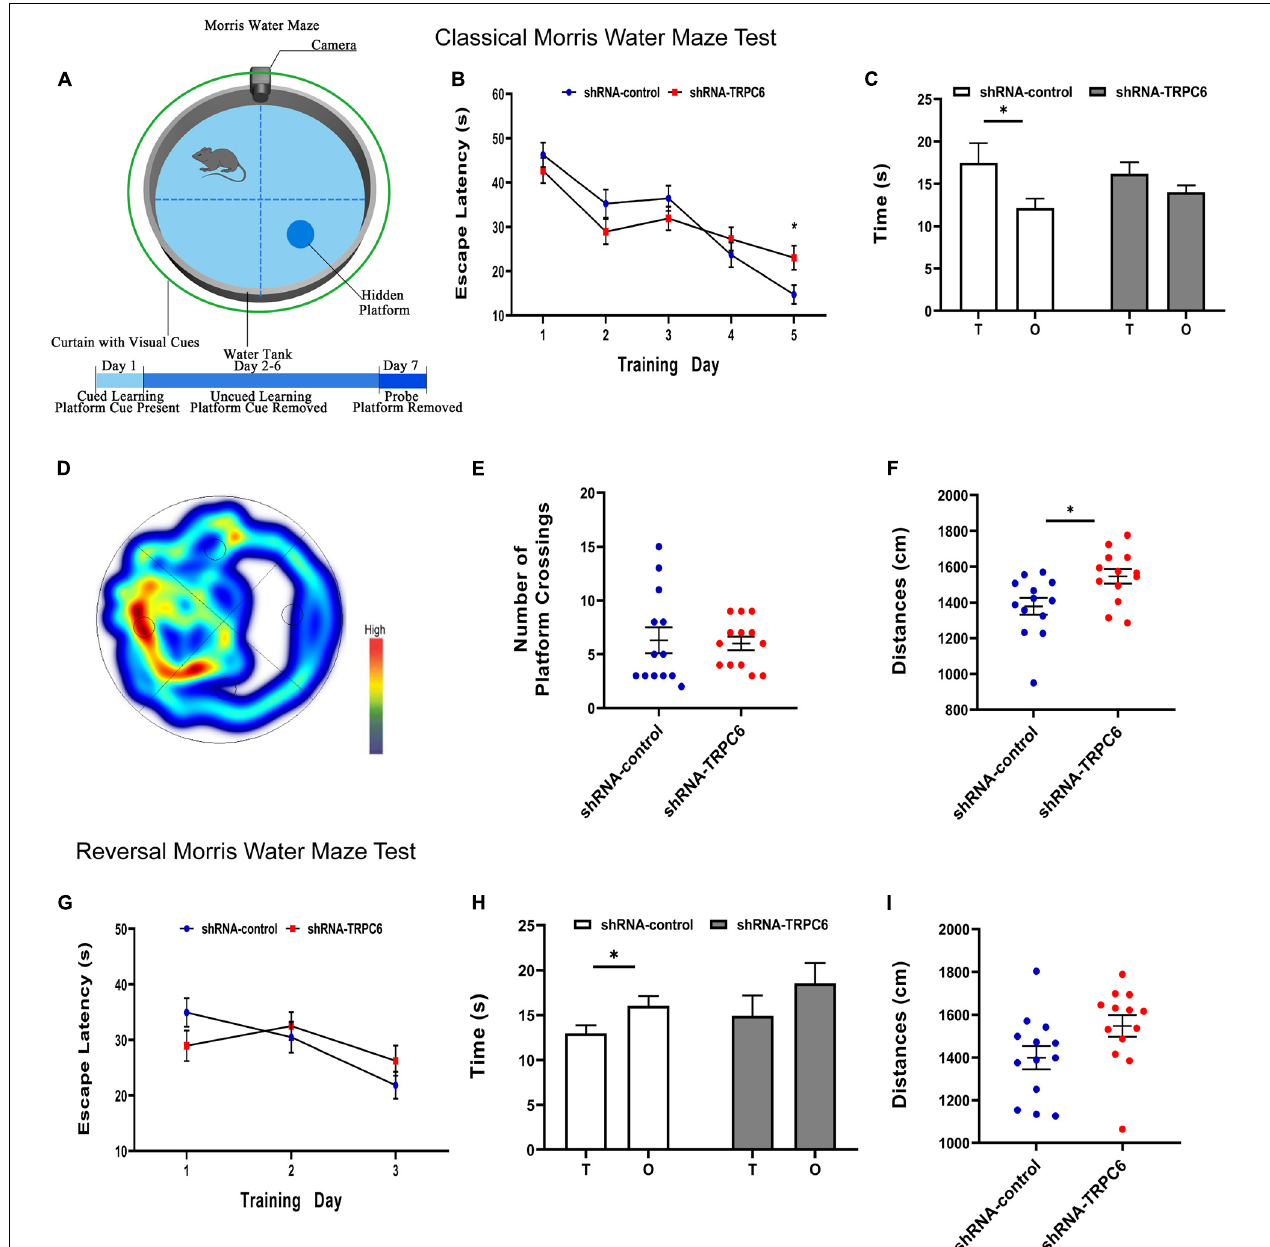
FIGURE 6 | Down-regulation of TRPC6 affected the spatial learning in the MWM test. (A) Experimental design in the MWM test. (B,G) Plots showing the average escape latencies of mice in the hidden platform test during the training days. Repeated measures ANOVA were used. * p < 0.05. (C,H) Time spent in target quadrant (T) and opposite quadrant (O) in the probe test. * p < 0.05. (D) Heat map of shRNA-TRPC6 treated mice during the navigation trials. (E) The number of platform crossings shown in the scatter plot. (F,I) Scatterplots showing the distances by mice in the two groups during the probe test. Sample sizes for each group: n = 13. Data were presented as mean ±